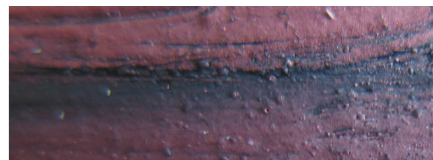
Figure 6: A close-up photo of partially sintered antenna in Sample 7.